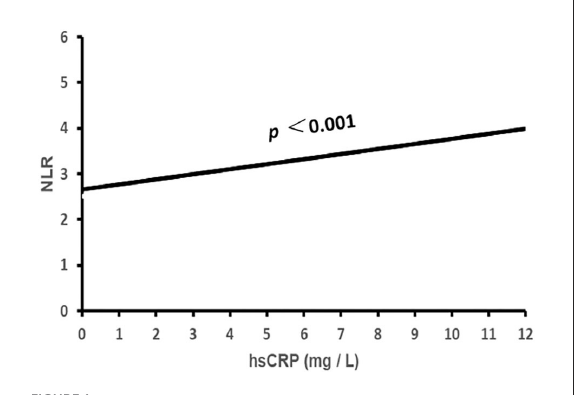
FIGURE1 The association of NLR with hsCRP. NLR, neutrophil to lymphocyte ratio; hsCRP, high sensitivity C-reactive protein.